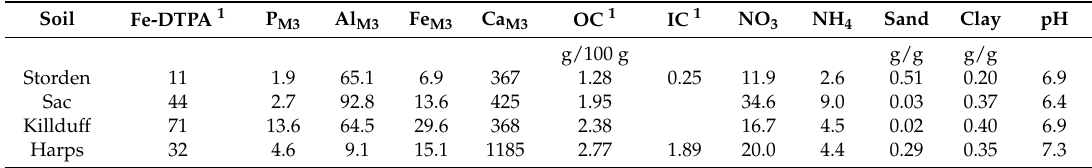
Table 1. Properties of soils used in the study. Nutrient levels were mg kg − 1